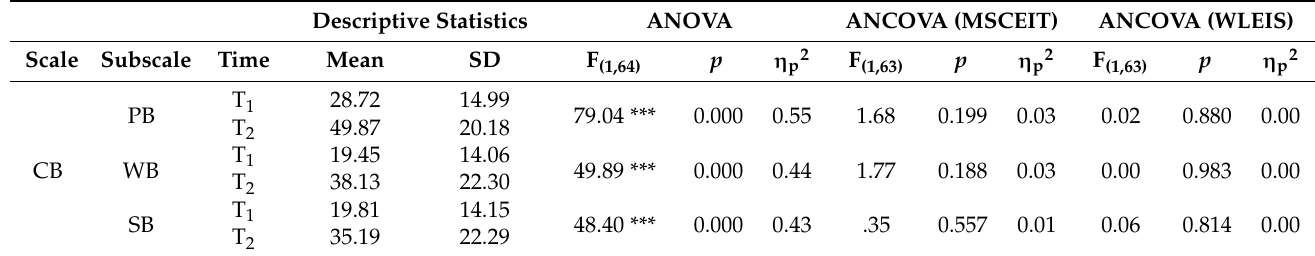
Table 2. Repeated measures ANOVA and ANCOVA results for burnout.